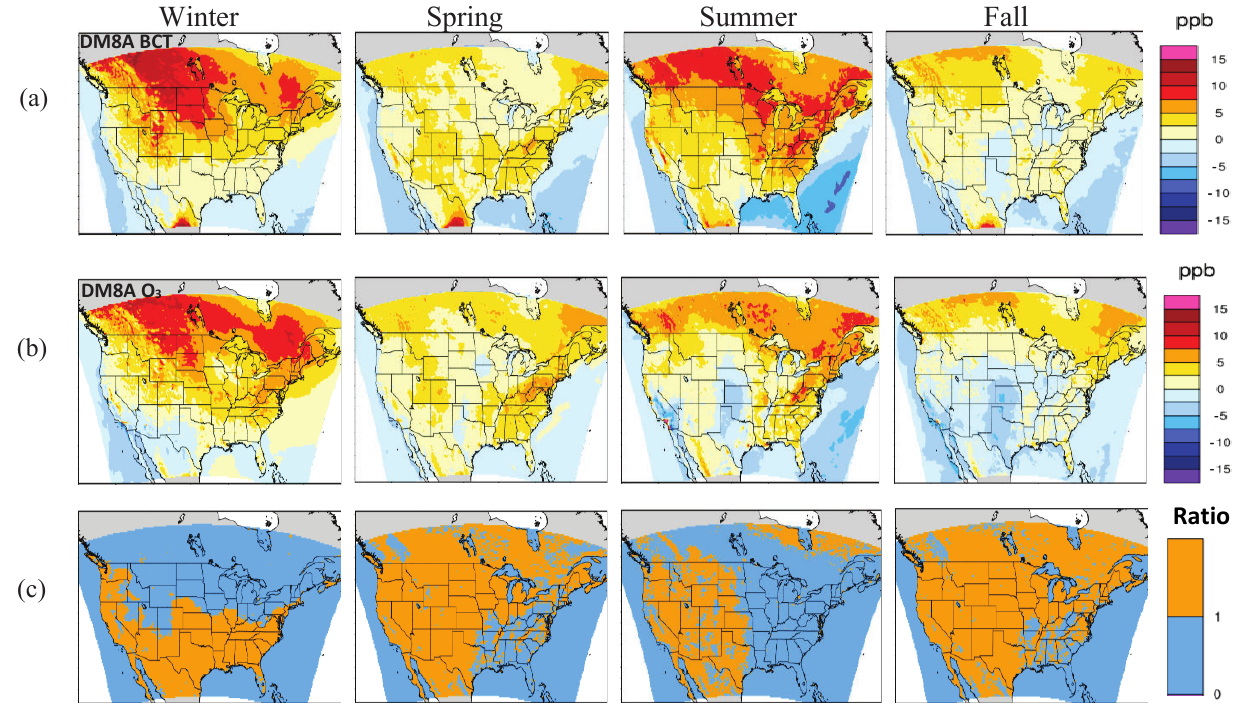
Figure 7. Differences in the seasonal averaged DM8A BCT (in ppb, a ) and DM8A O 3 (b) between WRF / CAMx and WRF / CMAQ (WRF / CAMx minus WRF / CMAQ) in the analysis domain. (c) The seasonal averaged ratio of dry deposition velocity (WRF / CAMx over WRF / CMAQ) for ozone. The areas in white or grey are the grid cells that are out of the simulation domain.